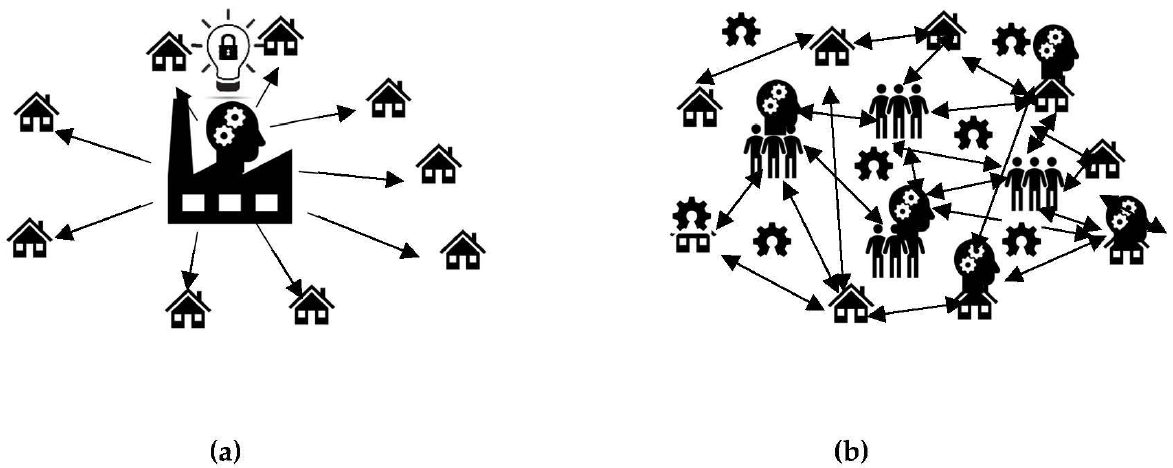
Figure 2. ( a ) Conventional centralized and proprietary manufacturing model and ( b ) the decentral- ized open-source hardware model (design and share globally, while manufacturing locally).